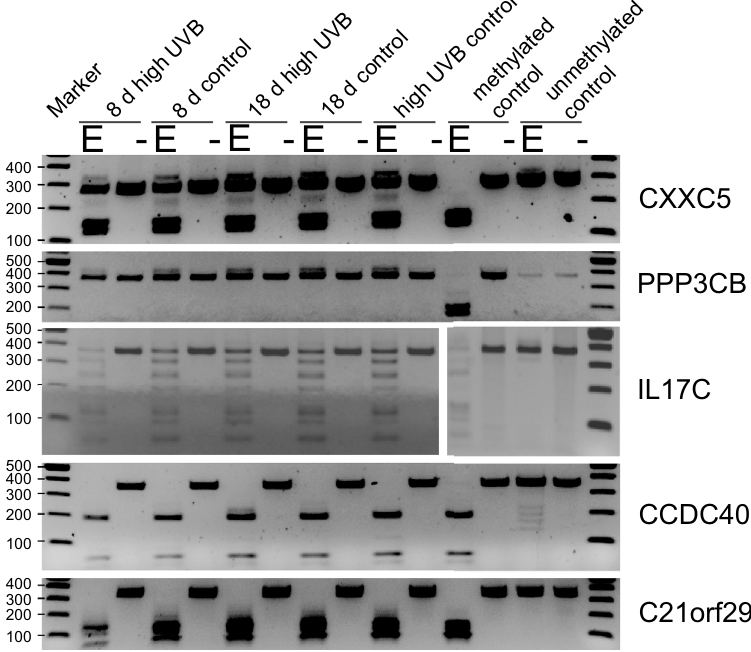
Figure 3. DNA methylation analysis by COBRA of candidate differentially methylated genes. COBRA analysis of restriction enzyme sites indicates no substantial difference in DNA methylation in UVB-irradiated cells versus controls. Samples labeled ‘8 d high UVB’ and ‘18 d high UVB’ were chronically irradiated with 260 J/m 2 of UVB followed by an 8 day or 18 day recovery period, respectively. Samples labeled ‘8 d control’ or ‘18 d control’ were grown for the same time periods as the irradiated cells but were never irradiated. The samples labeled ‘high UVB control’ represent DNA immediately harvested following a one-time irradiation of cells with 260 J/m 2 of UVB. The genes CXXC5 , PPP3CB, IL17C, CCDC40 and C21orf29 were analyzed by Taq α I digestion. The PCR products were cleaved with the enzyme (E) or were left uncleaved (-). The methylated and unmethylated control samples at the right side of the gel panels were fully CpG-methylated and unmethylated control